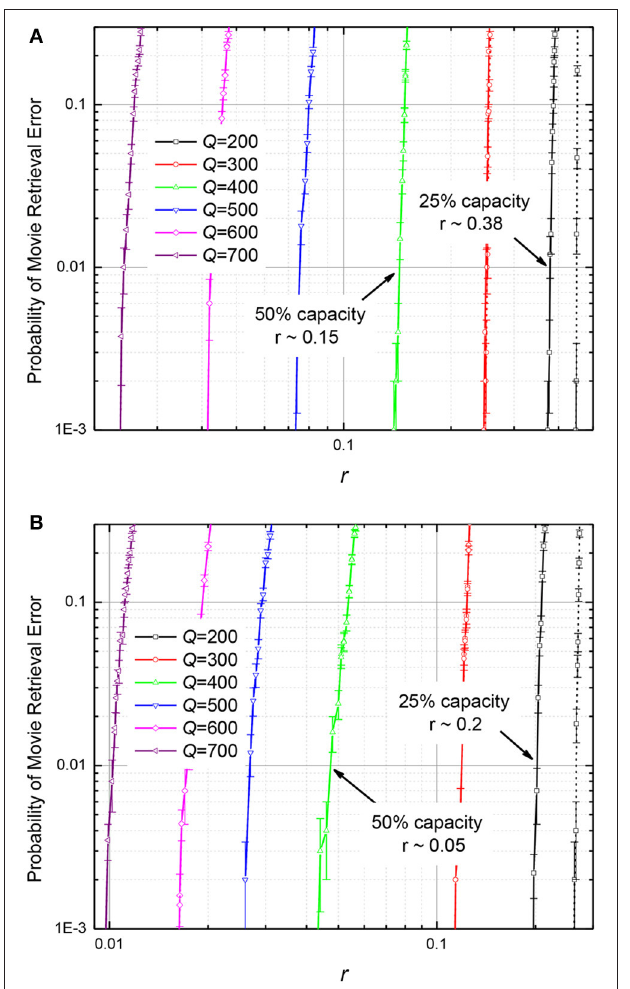
FIGURE 11 | The probability of movie retrieval error in the ASTMs with M 440, using (A) the quadratic-programming recording, and (B) the discrete = gradient-descent recording, as functions of the normalized (relative) r.m.s. deviation r of the synaptic weights from the optimal (calculated) values. Solid lines represent the 99% fidelity of recovery, while the dashed lines, the 97% fidelity. The error bars represent standard deviation of the mean based on 1000 simulations (10 randomly generated movies, 100 tests per movie).